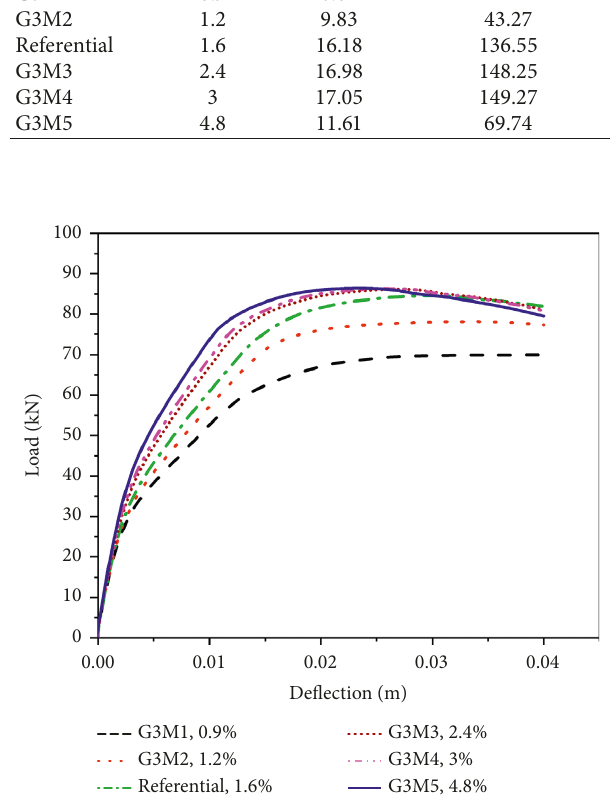
Figure 20: Load-deflection response of specimens with various tensile reinforcement